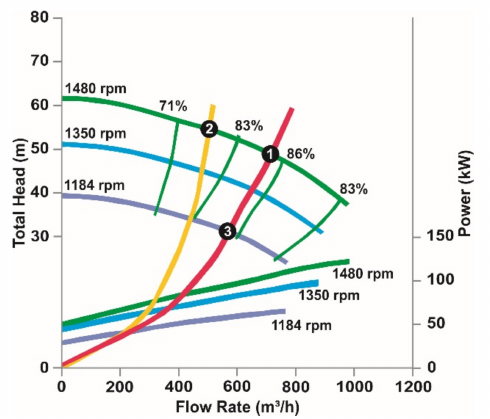
Figure 2. Scheme of VFDs and throttled valves operation, by